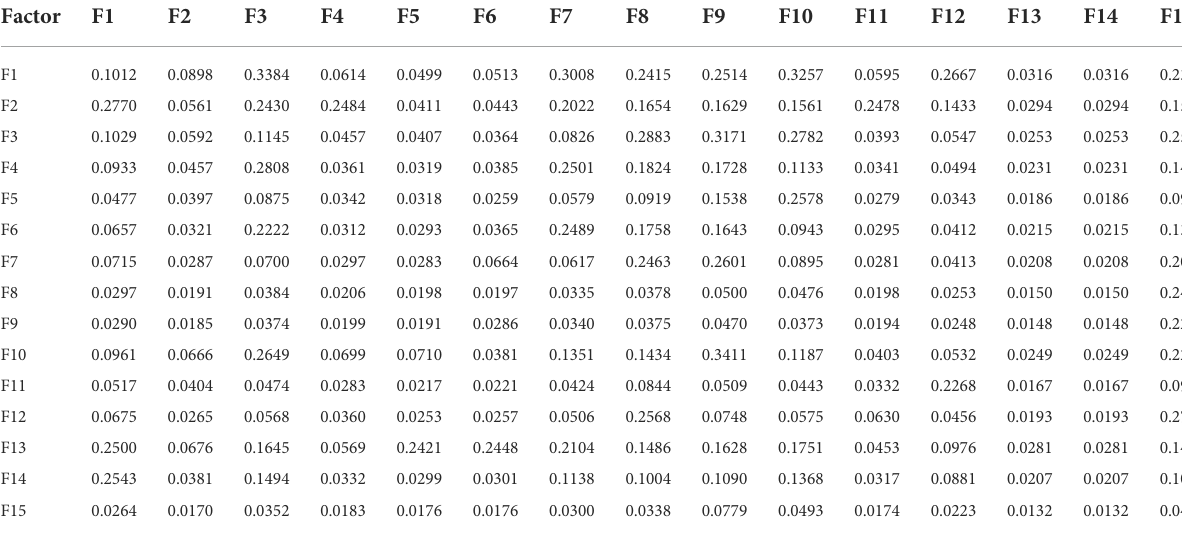
TABLE 4 Integrated in fl uence matrix.